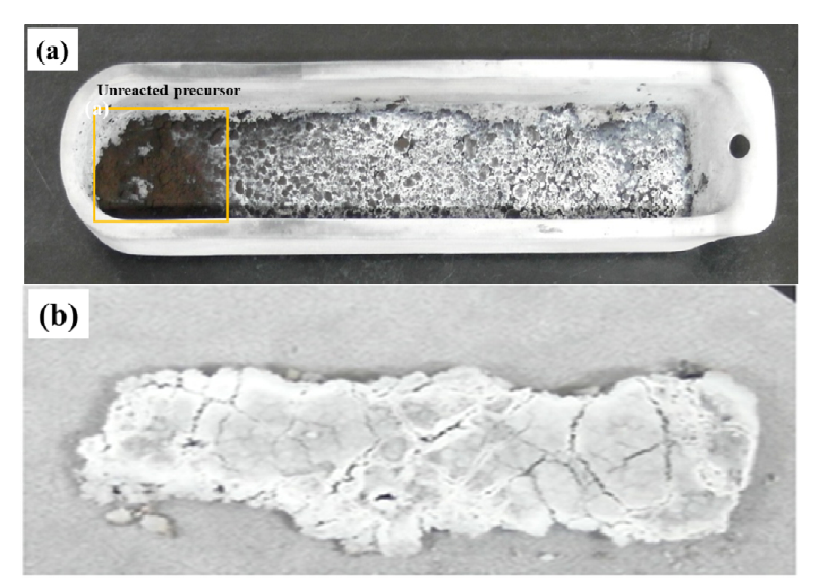
Figure 4. Comparison of the annealed samples synthesized from: ( a ) a conventional flow-through reactor; and ( b ) a nozzle-type